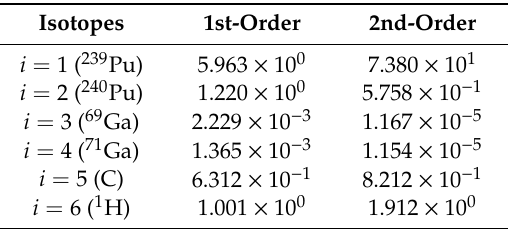
(cid:16) (cid:17)(cid:16) (cid:17) ∂ L / ∂ N N i , m / L , i = 1, ... ,6; m = 1,2 i , m (cid:16) (cid:17)(cid:16) (cid:17) ∂ 2 L / ∂ N ∂ N N i , m N i , m / L , i = 1, ... ,6; m = 1,2 for i , m i , m